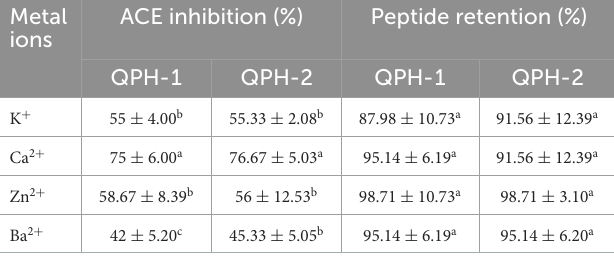
TABLE 4 Effects of different metal ions on the peptide yield and ACE inhibition rate. Metal ions